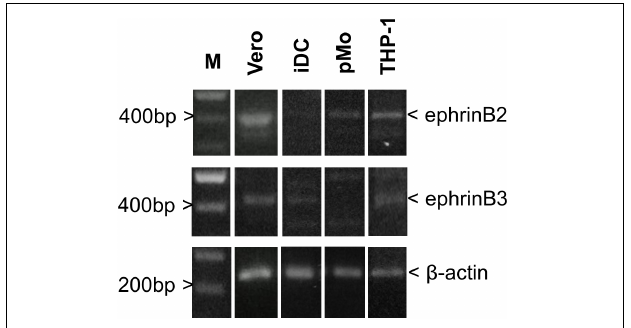
FIGURE 2 | PCR amplification for detection of endogenous mRNA levels of ephrinB2, ephrinB3 and β -actin in iDC, pMO, THP-1, and Vero cells. Amplified products were visualized on a 1.8% (w/v) agarose gel. Lane M – GeneRuler 100 bp DNA Ladder Plus (Promega, United States). Figure shows the representative results from two independently performed amplifications.